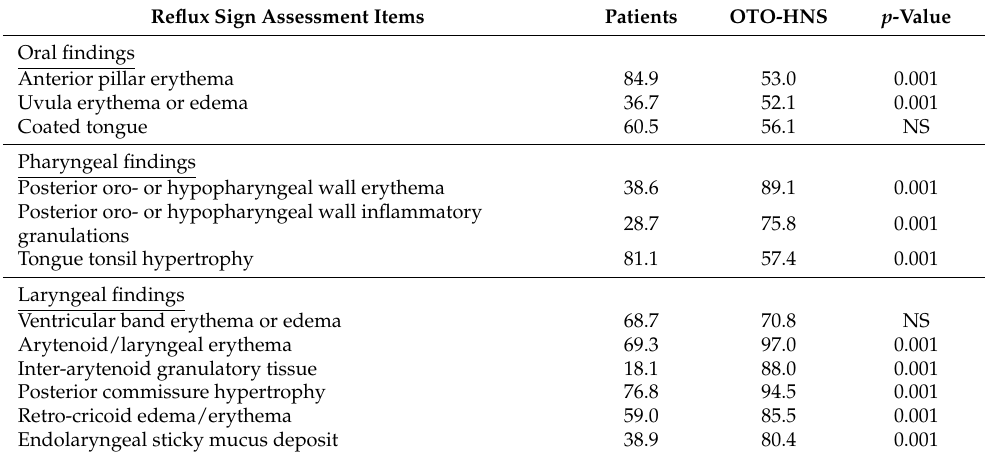
Table 3. Prevalence of signs according to patient cohort and otolaryngologists’